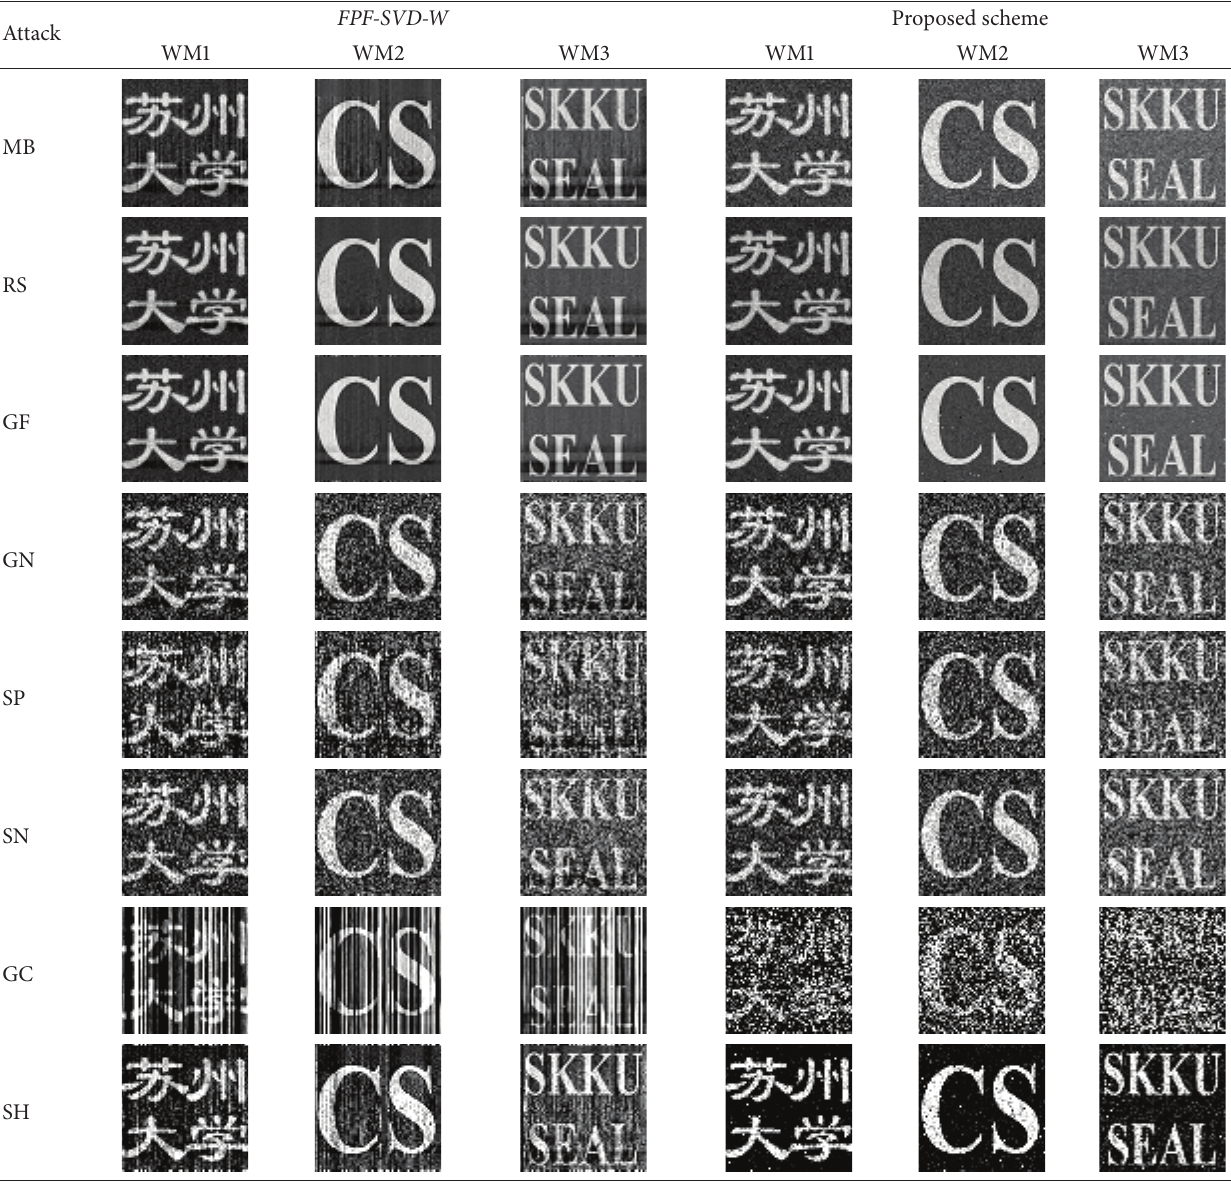
Table 7: Extracted watermarks from the watermarked images that are distorted by various